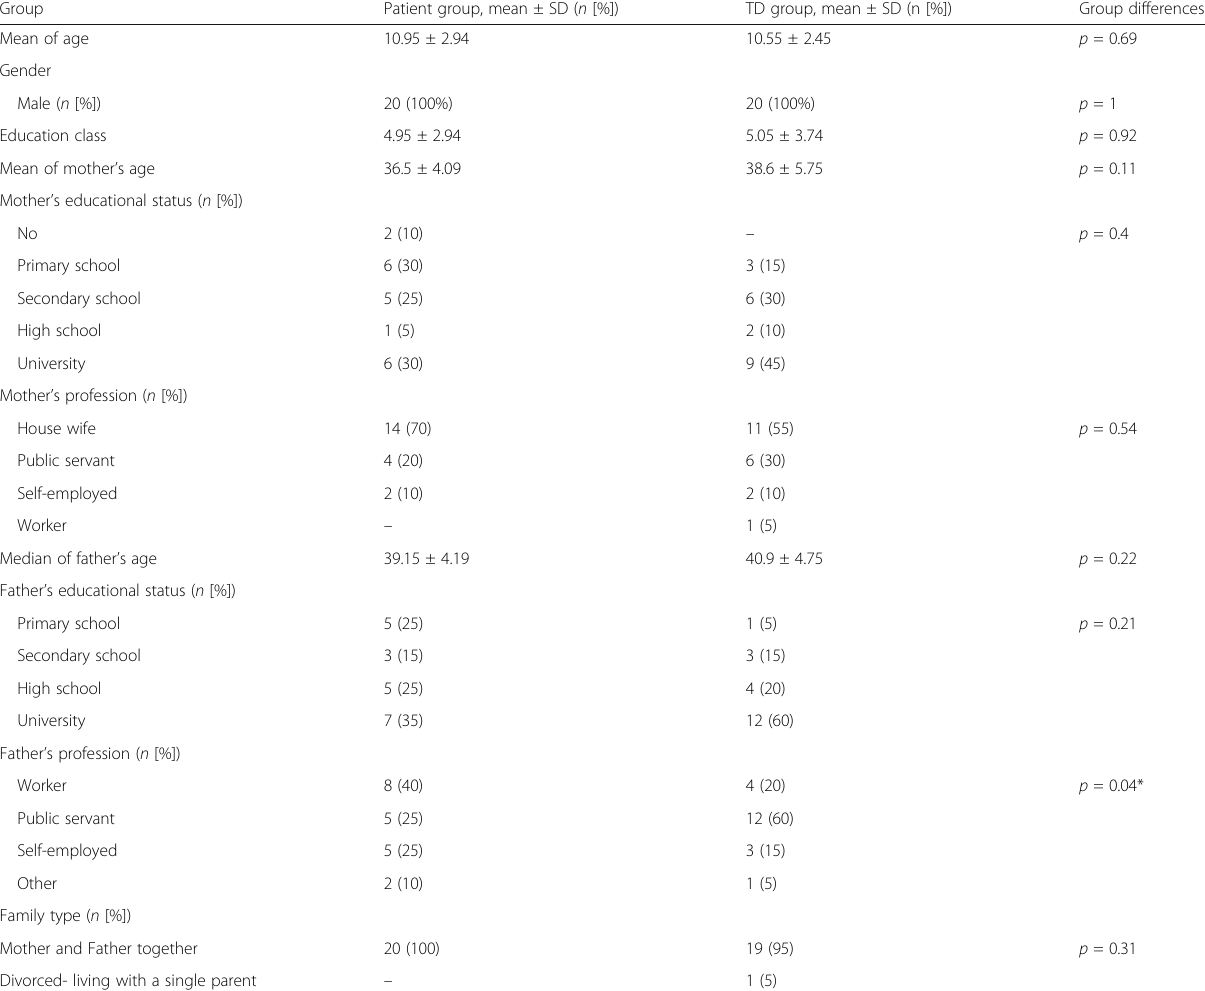
Table 3 Comparison of sociodemoghraphic variables between groups